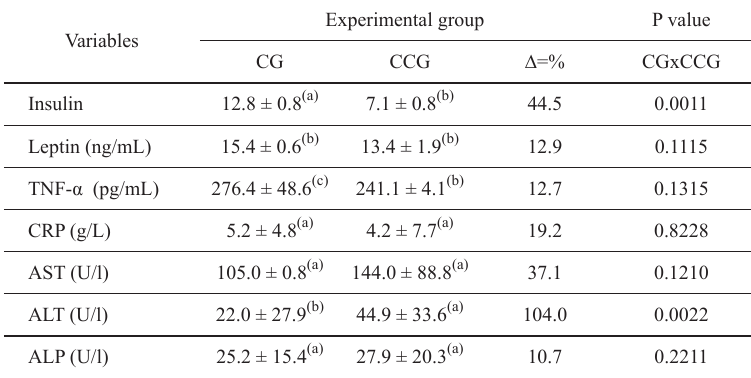
Biochemical and inflammatory profile of obese rats treated with Camu-camu